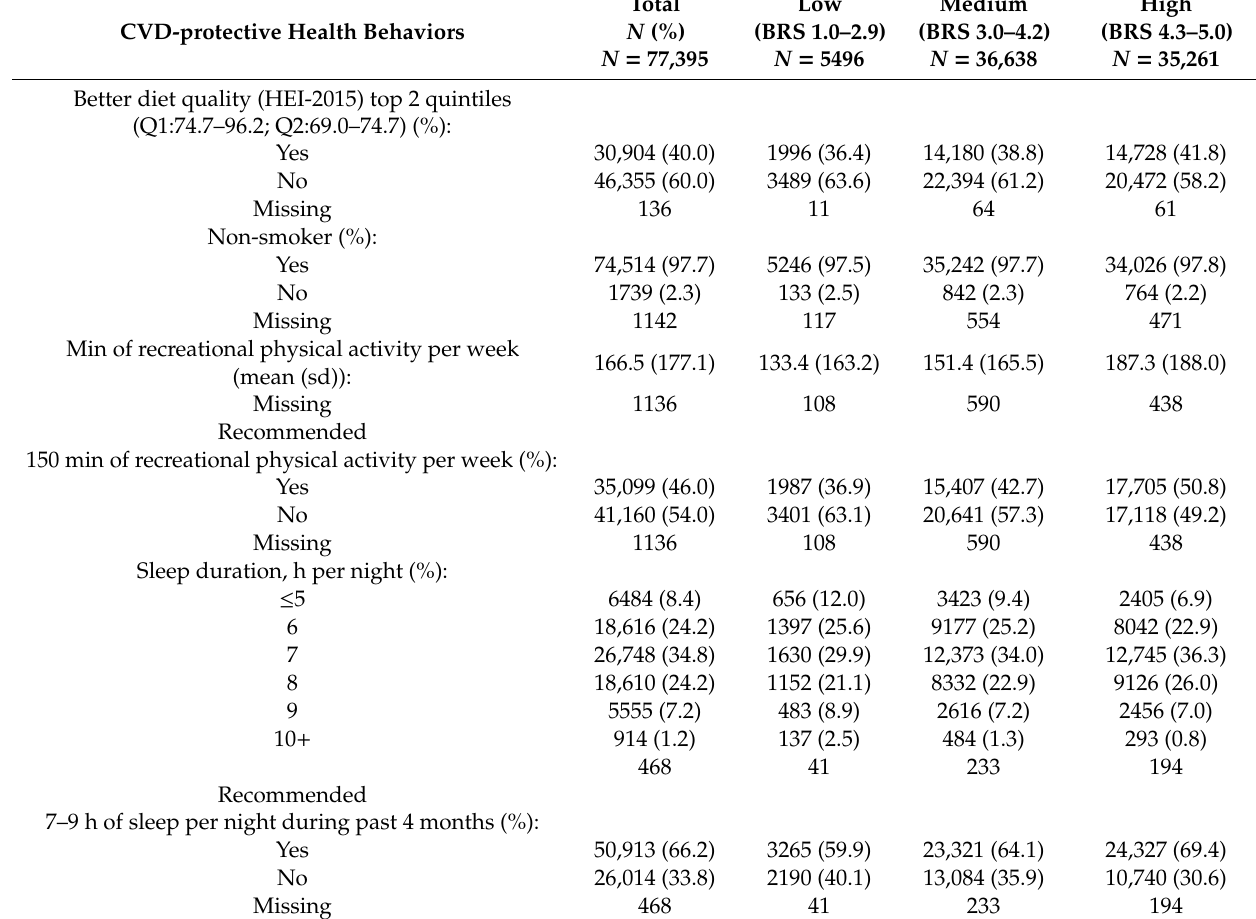
Table 2. CVD-protective health behaviors by low, medium, and high levels of self-reported psychological resilience from participants in the Women’s Health Initiative (WHI) Extension Study